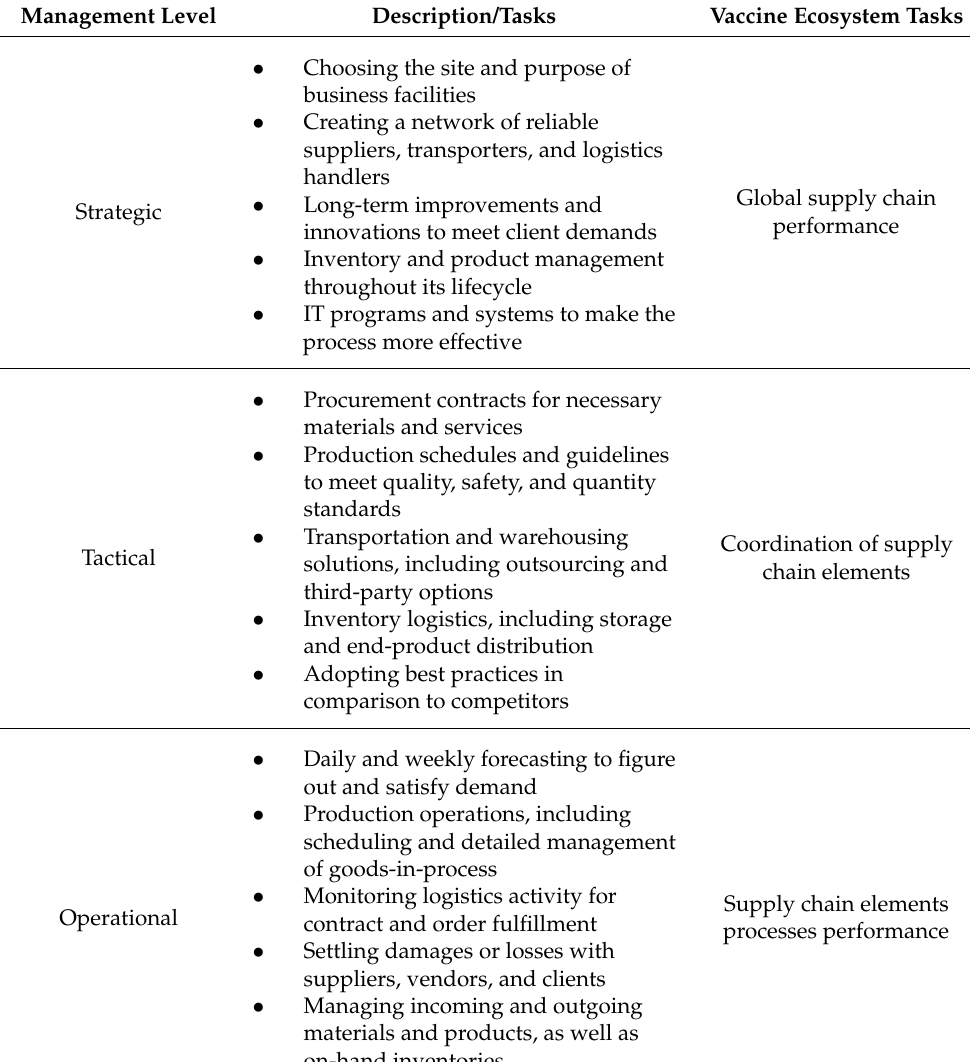
Table 2. Vaccine ecosystem management levels.